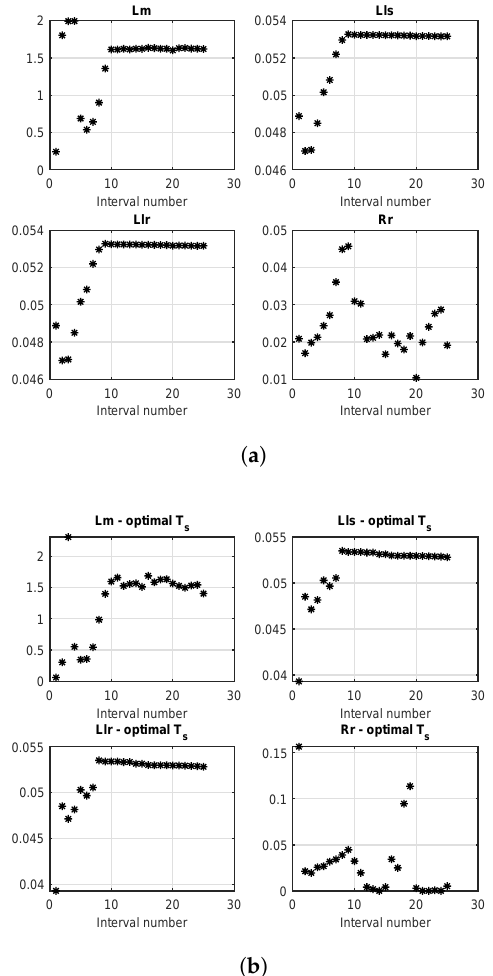
Figure 6. Motor parameters (p.u.) estimated for each interval with ( a ) original sampling time and ( b ) optimal sampling